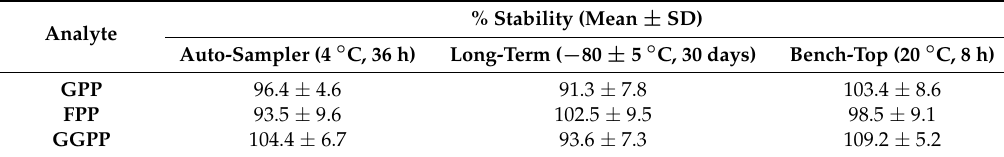
Table 4. Mean stability of the GPP, FPP and GGPP at different storage conditions in human